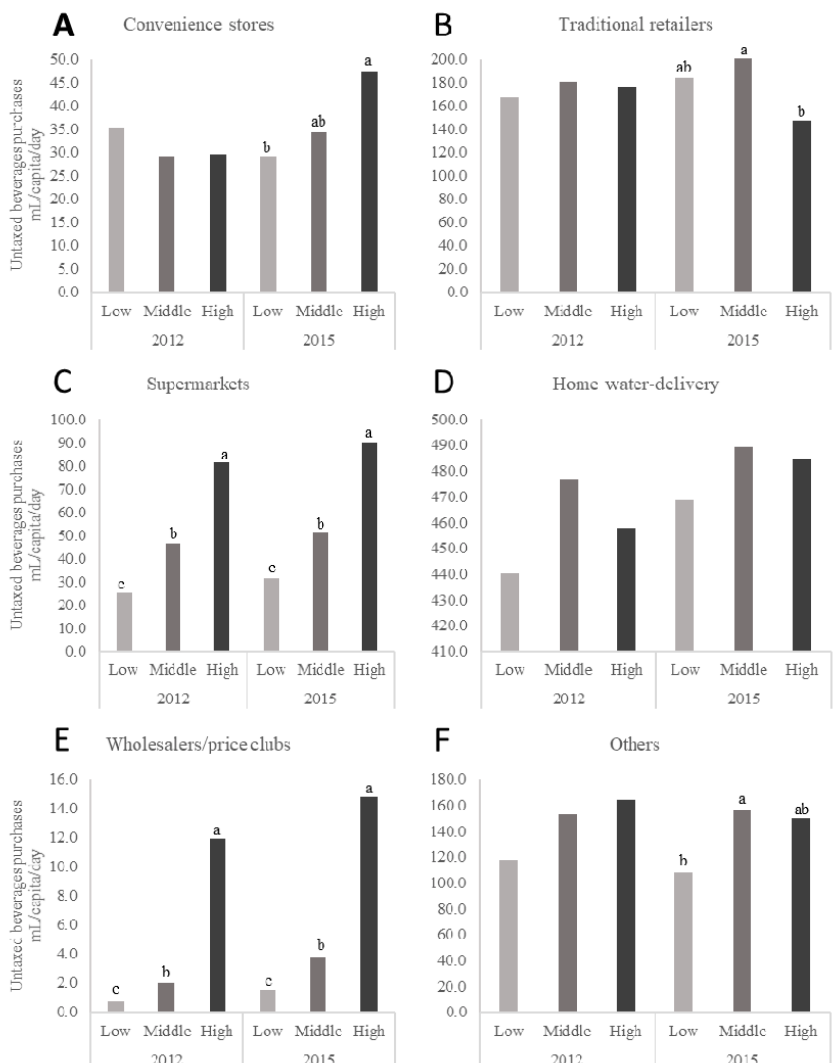
Figure 2. Daily per capita purchases of untaxed beverages in urban Mexican households according to SES for the years 2012 and 2015. n = 959 in the low-SES, n = 3133 in the medium-SES, and n = 1721 in the high-SES group in 2012 and n = 1170 in the low-SES, n = 2690 in the medium-SES, and n = 1633 in the high-SES group in 2015. Subgraphs refer to untaxed beverage purchases by store-type including ( A ) convenience stores, ( B ) traditional retailers, ( C ) supermarkets, ( D ) home water-delivery, ( E ) wholesalers and price clubs, and ( F ) Other sources Values represent weighted unadjusted means. SES classification is based on the socioeconomic index provided by Nielsen. Multivariate linear regression models were used to predict per capita daily purchases of untaxed beverages according to store-type, SES, and year of purchases. Data presented are restricted to the Nielsen CPS purchasing information for 2012 and 2015 only for clarity. However, p -values represent the p -trend for years 2012, 2013, 2014, and 2015. Labeled means with a different letter represent significant differences between the SES categories means ( p -trend < 0.05) where the letters a,b,c are used to differentiate the highest, middle, and lowest mean values for each figure in the panel. Source: Authors’ own analyses and calculations based on data from Nielsen through its Mexico Consumer Panel Service (CPS) for the food and beverage categories for January 2012 to December 2015. The Nielsen Company, 2016. Nielsen is not responsible for and had no role in preparing the results reported